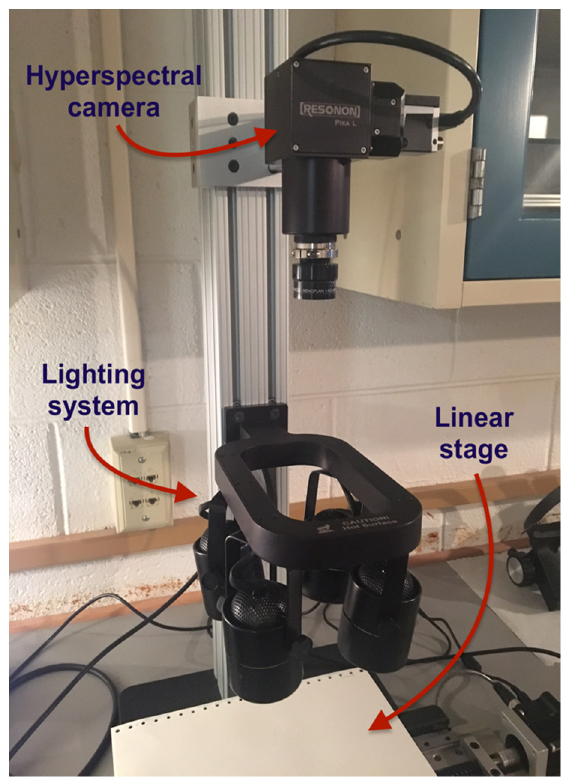
Figure 2. Hyperspectral camera setup, including halogen lighting system and linear stage.